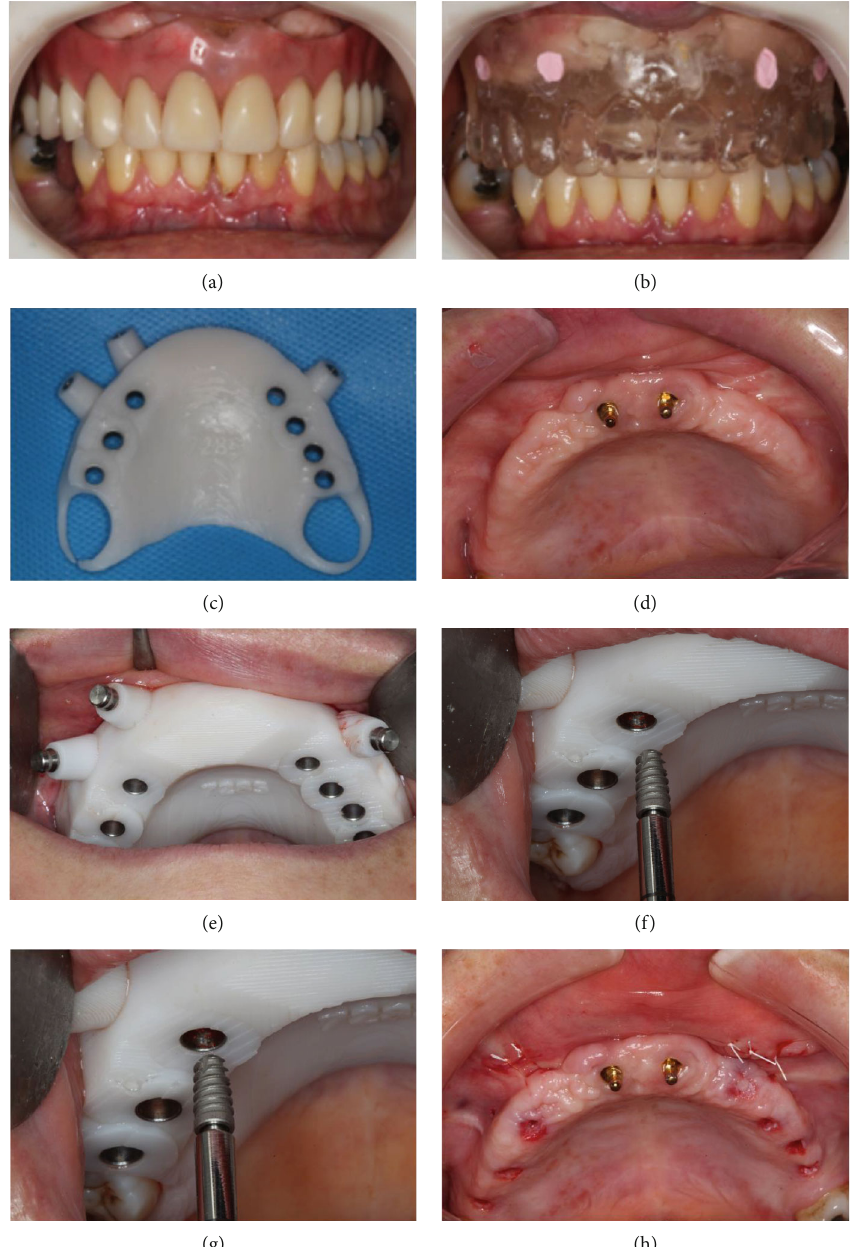
Figure 7: After a healing period of 8 months from the maxillary sinus augmentation procedure, the implants were installed by means of guided surgery. Seven implants were planned and installed in the posterior area of the maxilla (a –